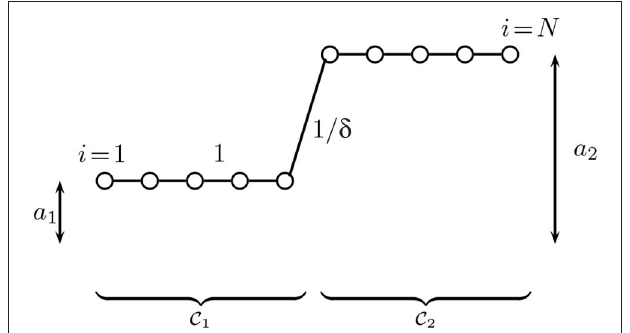
[ i ] (cf. (2)) defined [ i ] + a 2 I C FIGURE 1 | A clustered graph signal x [ i ] = a 1 I C 2 1 over a chain graph G chain which is partitioned into two equal-size clusters C 1 and C 2 which consist of consecutive nodes. The edges connecting nodes within the same cluster have weight 1, while the single edge connecting nodes from different clusters has weight 1 /δ . FIGURE 2 | Clustered graph signal x [ i ] along with the recovered signals obtained from sampling sets M 1 and M 2